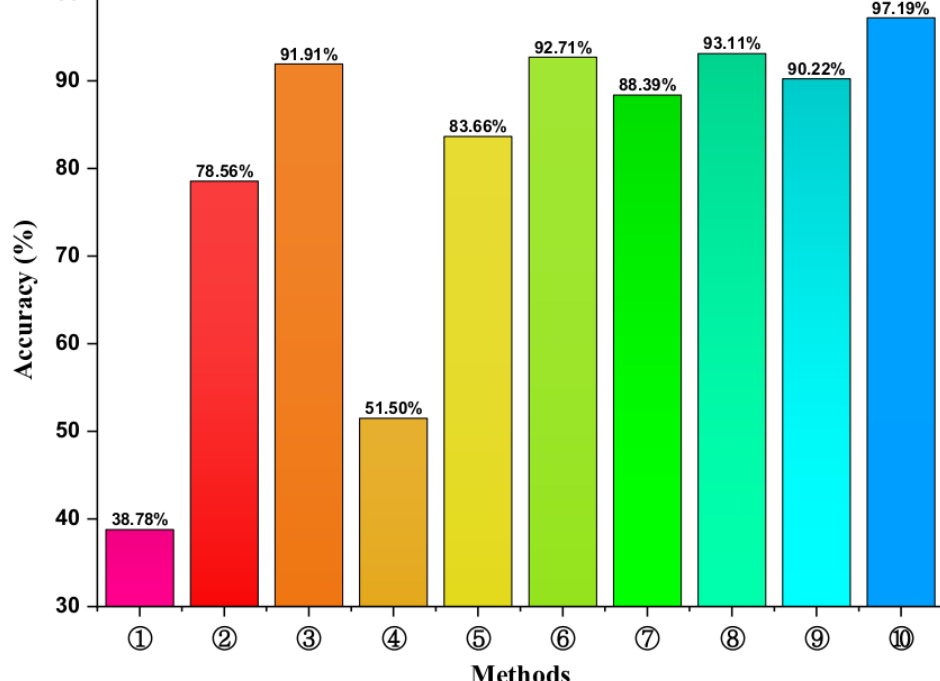
Figure 12. Average accuracy under different